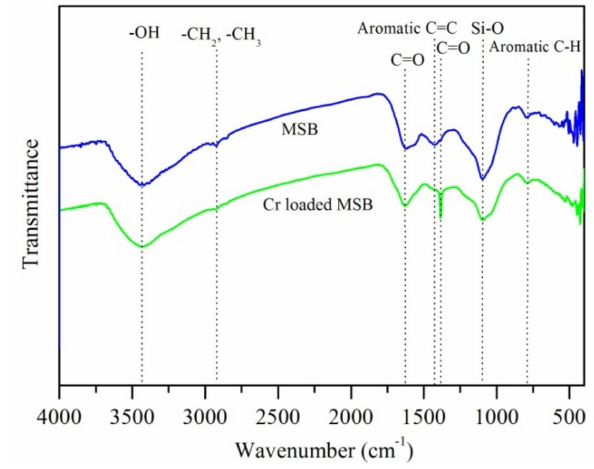
Figure 9. FTIR spectra of MSB before and after reaction with 200 mg / L Cr(VI) for 48 h at pH